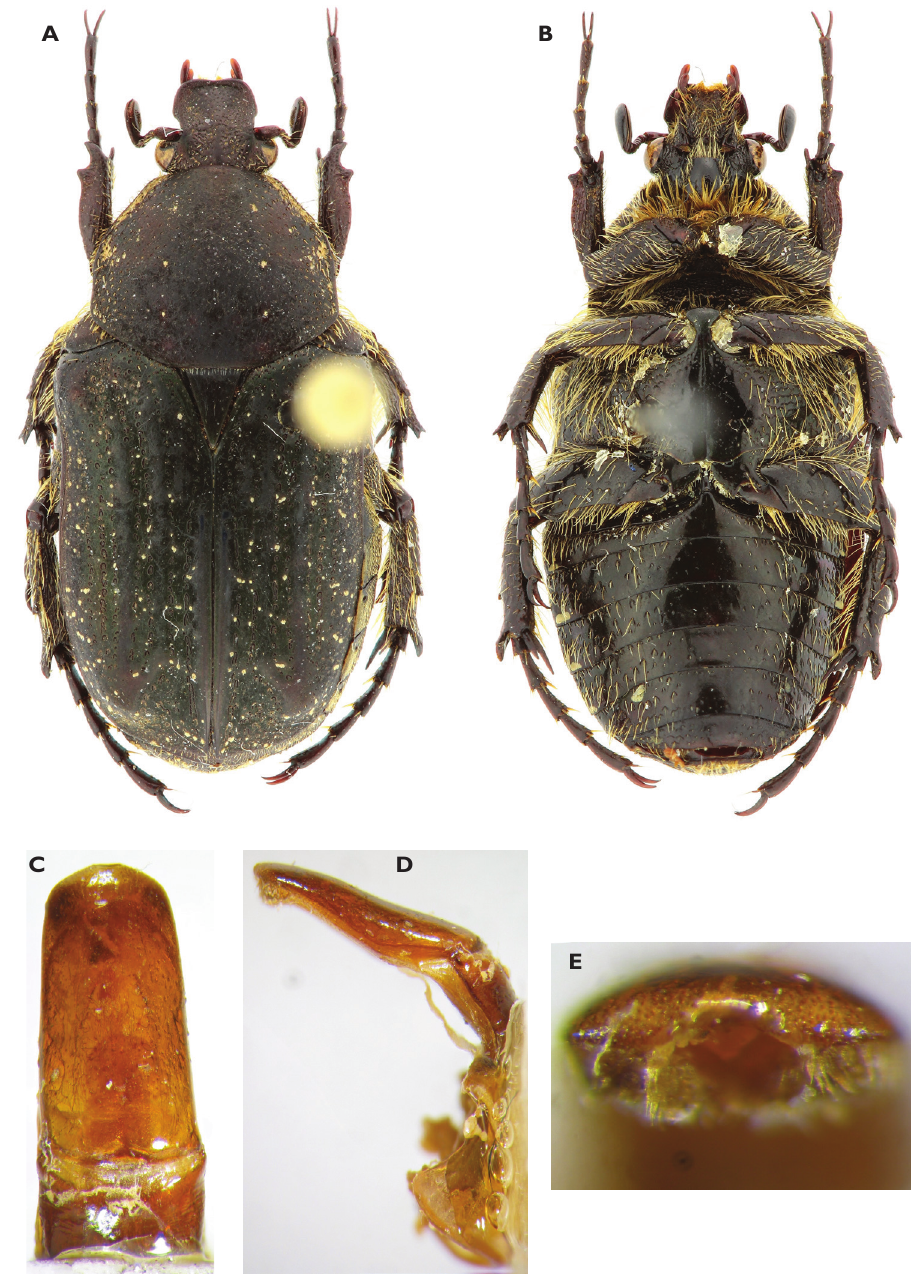
Figure 17. Atrichelaphinis ( Eugeaphinis ) vermiculata (Fairmaire, 1894), male, Erythrea (PCSR). A Dorsal view B ventral view C parameres in dorsal view D parameres in lateral view E apex of